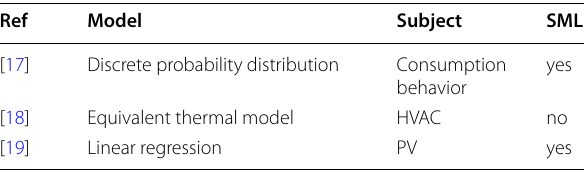
Table 1 PV and HVAC models